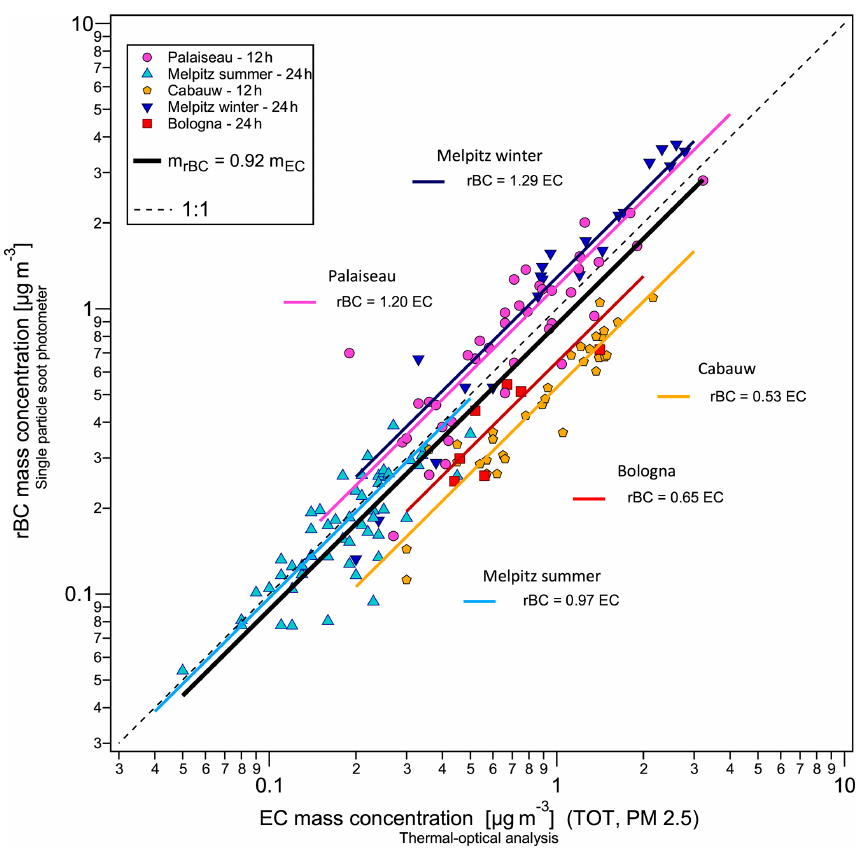
Figure 3. The rBC mass concentration versus EC mass concentration for the five campaigns studied in this paper. The median rBC-to-EC mass ratios are shown as lines for each campaign. Uncertainties in EC measurements as a function of EC and TC filter surface loadings as well as EC-to-TC mass ratio are presented in Fig. S3 and discussed in Sect.